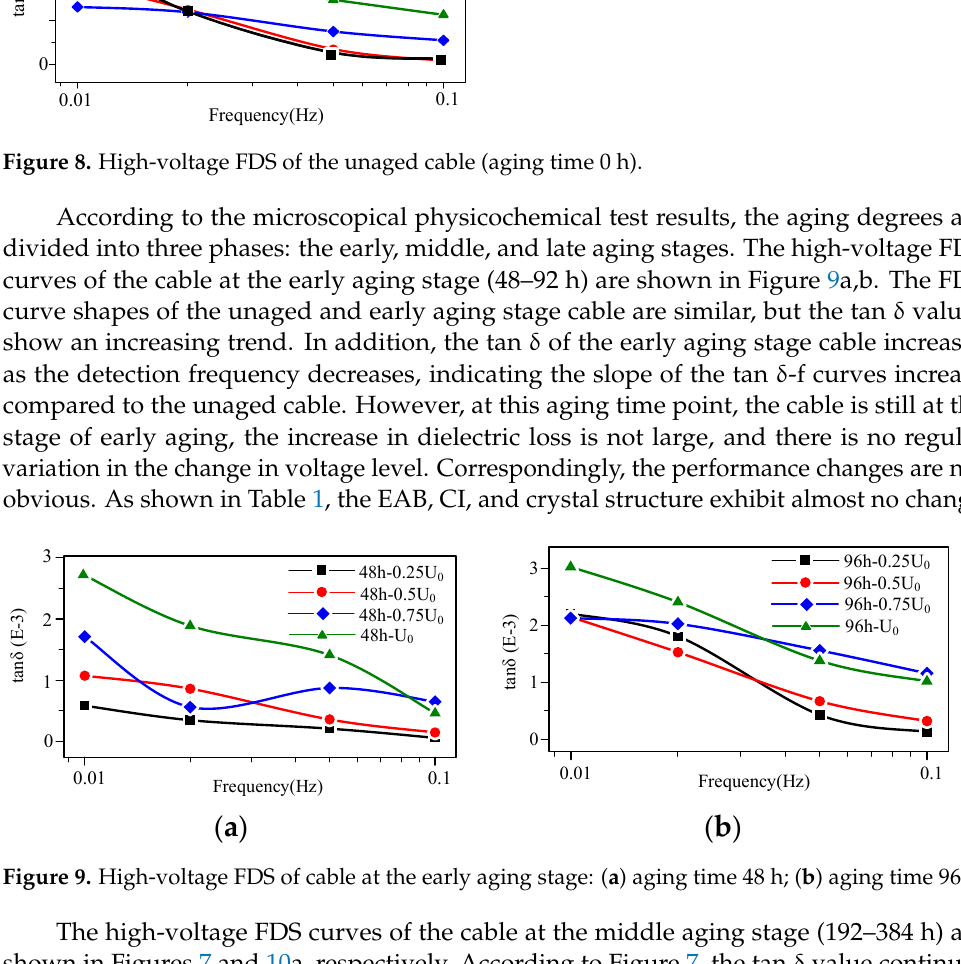
Figure 8. High-voltage FDS of the unaged cable (aging time 0 h).